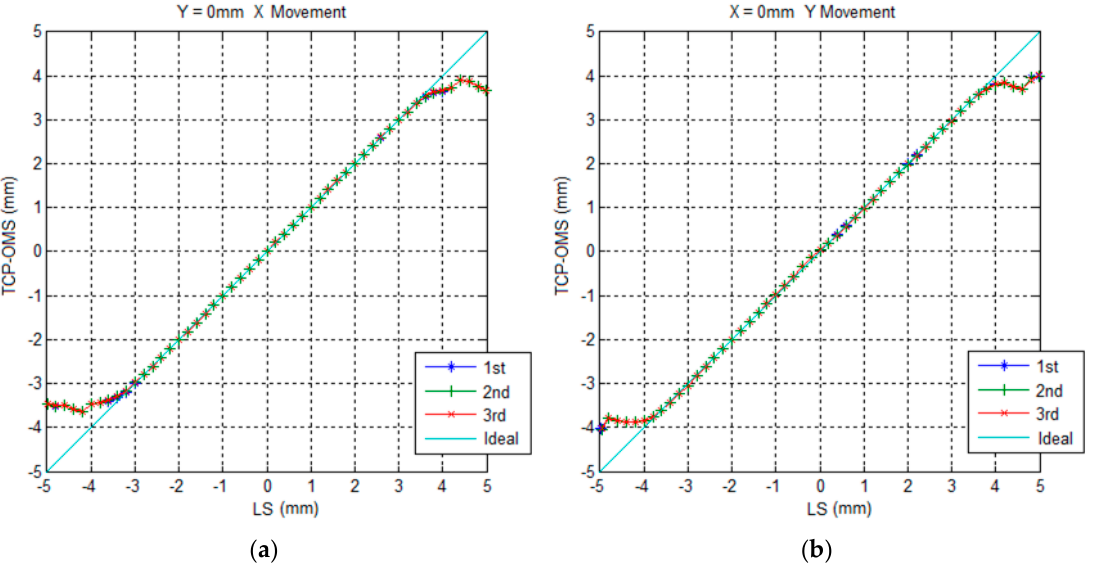
Figure 17. Measuring data of TCP − OMS are compared with LS on machine. ( a ) TCP moves along the X − axis; ( b ) TCP moves along the Y − axis.